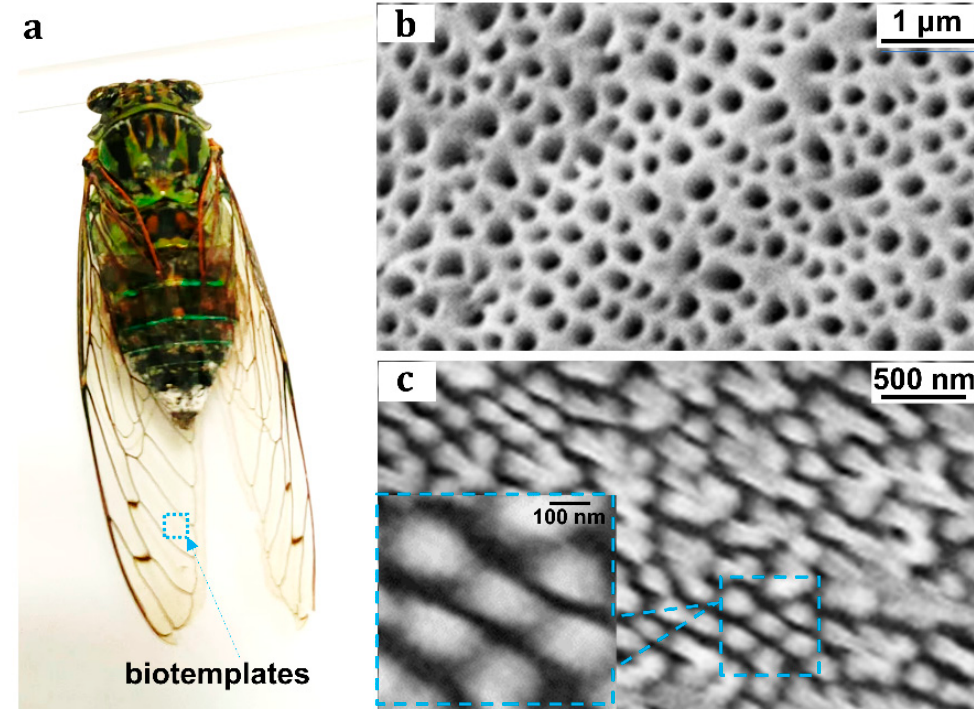
Figure 3. ( a ) Image of Chinese cicada “meimuna mongolica” as bio-template for bionic nano-im- printing. ( b ) The morphology of the inverse nanostructures (after the first imprinting) characterized by scanning electron microscope (SEM). ( c ) The morphology of the copied nanostructures (after the second imprinting) characterized by SEM.